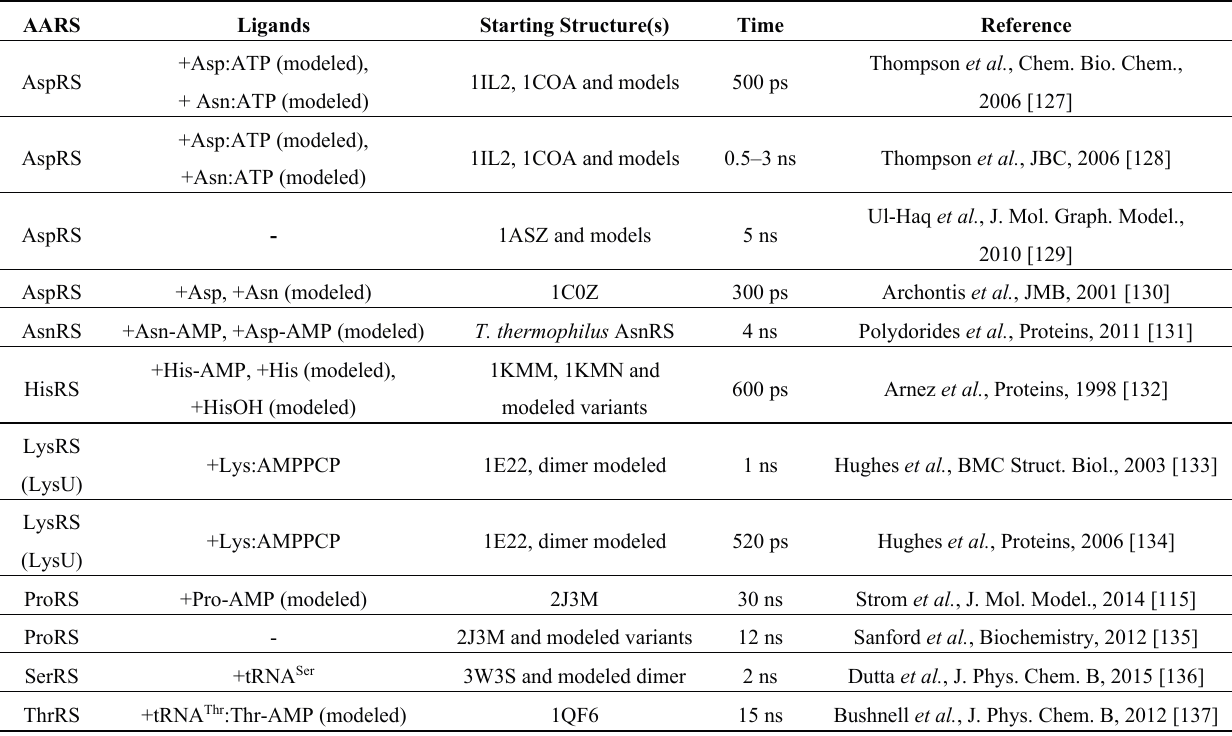
Table 3. MD Simulations of Class II